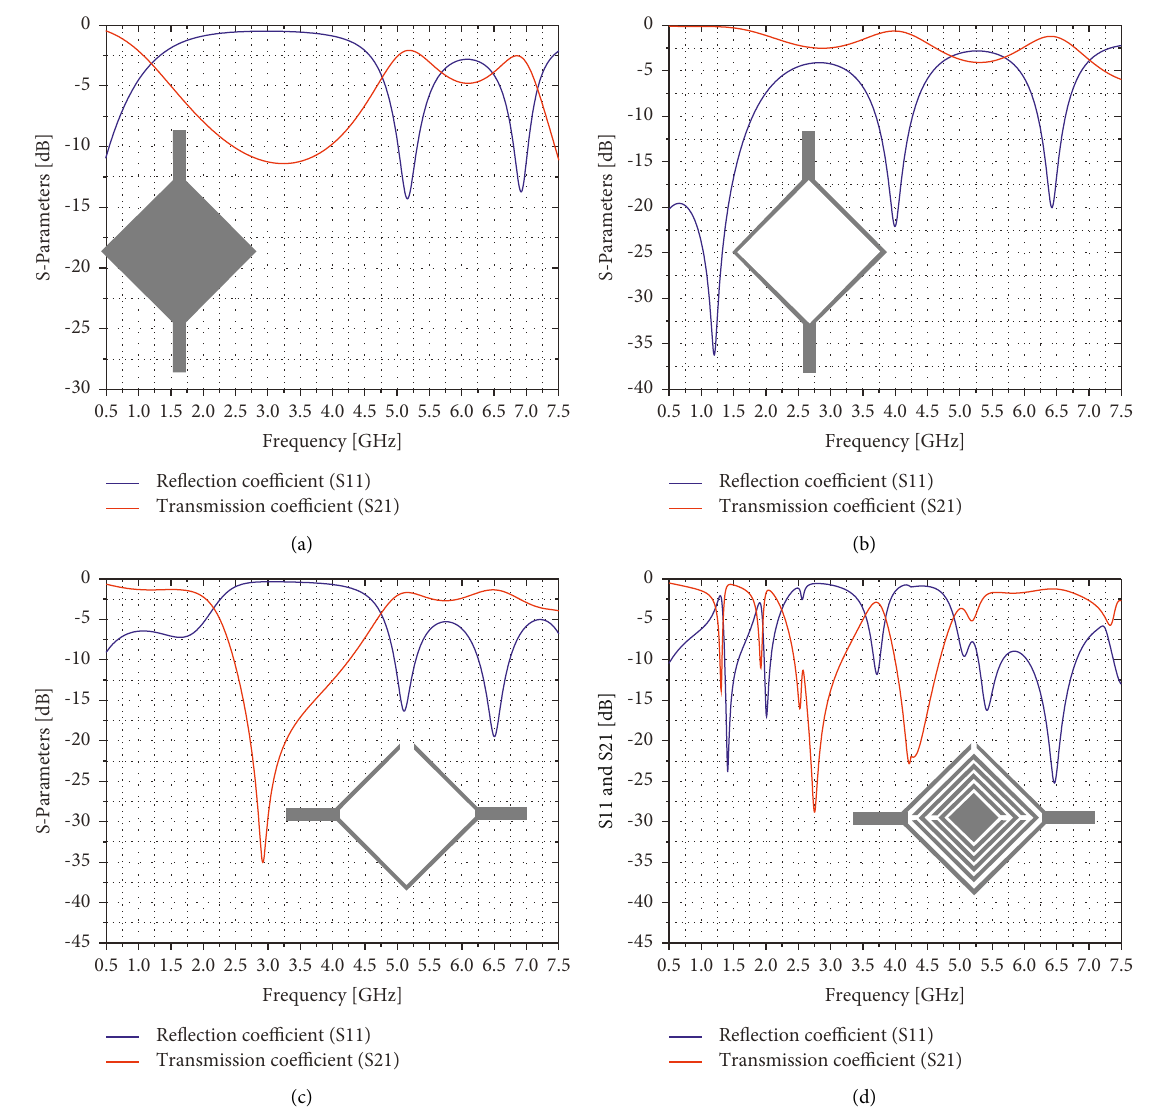
Figure 3: Design process of the proposed hybrid quadband lowpass-passband filter: (a) Step 1, (b) Step 2, (c) Step 3, and (d) Step 4.